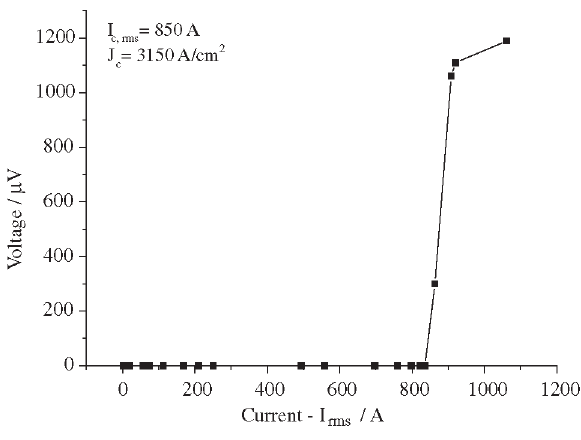
Figure 10. I material obtained by PMR.